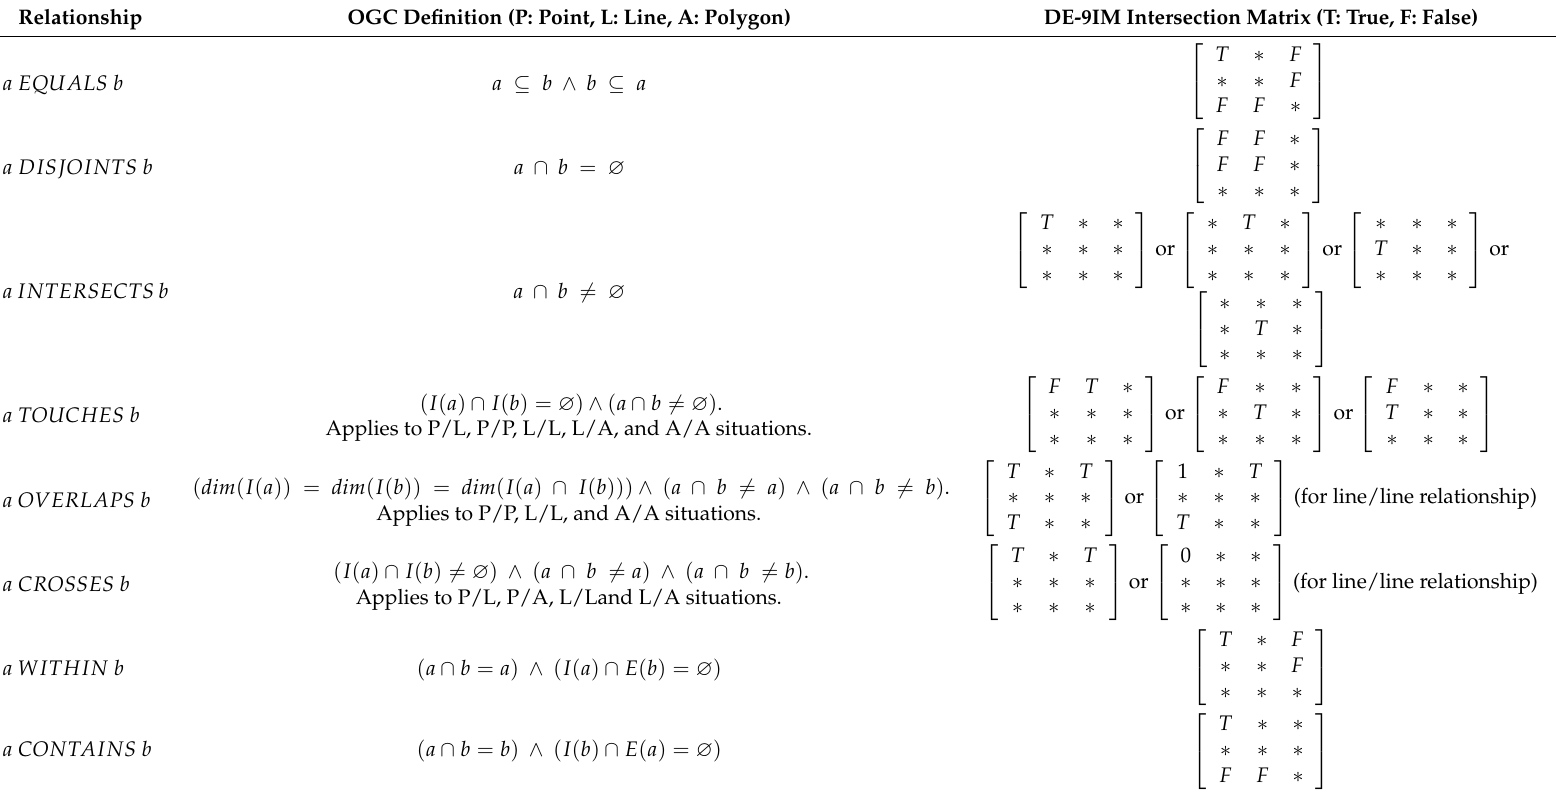
Table 1. The topological relationships and their corresponding intersection